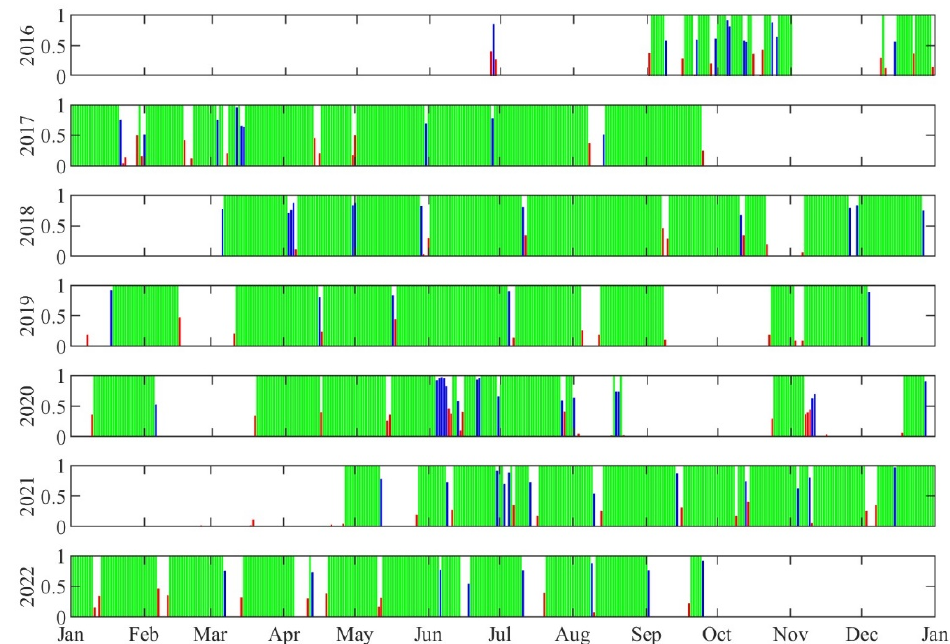
Figure 4. Timeline highlighting data availability for OSU1, the array began recording in September 2016 and was decommissioned in September 2022. Bars indicate the percentage of the day recorded. Bars are colored (green) for 100%, (blue) for >50%, and (red) for <50% of data availability for the day. Blank areas indicate that the array was not recording data.